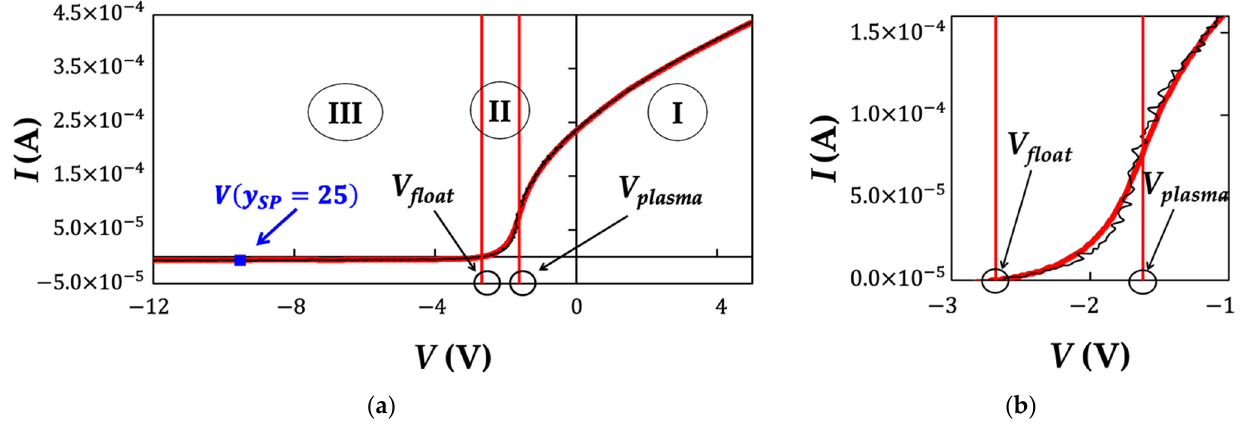
Figure 4. IVCP experimental black squares and smoothed, red line; Sonin Plot potential in blue. Discharge conditions: Argon gas; p = 8.13 Pa; I d = 2.0 mA; V float = − 2.68 V; V plasma = − 1.62 V. ( a ) IVCP. ( b ) Zone of the IVCP for the calculation of the EEDF.